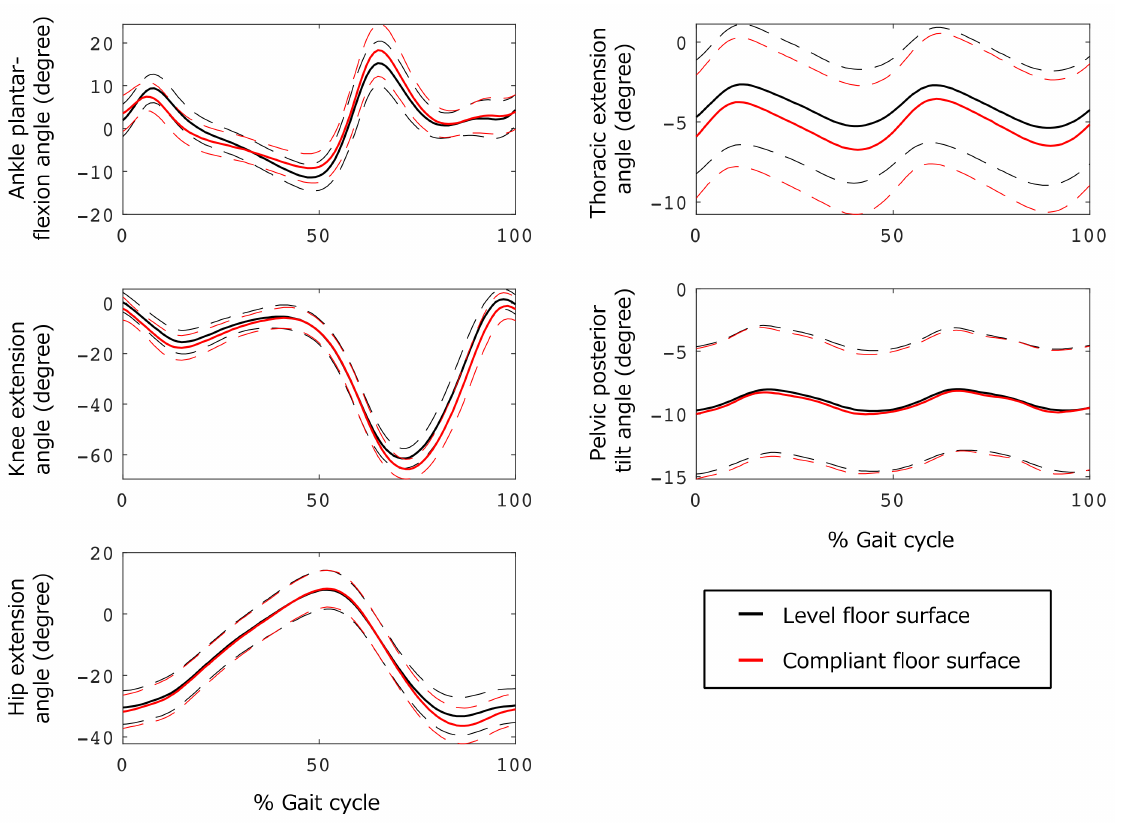
Figure 3. Average (solid line) and 1 SD (dashed line) of joint angle (left line) and segment angle (right line) during gait cycle on the level surface (black) and compliant surface